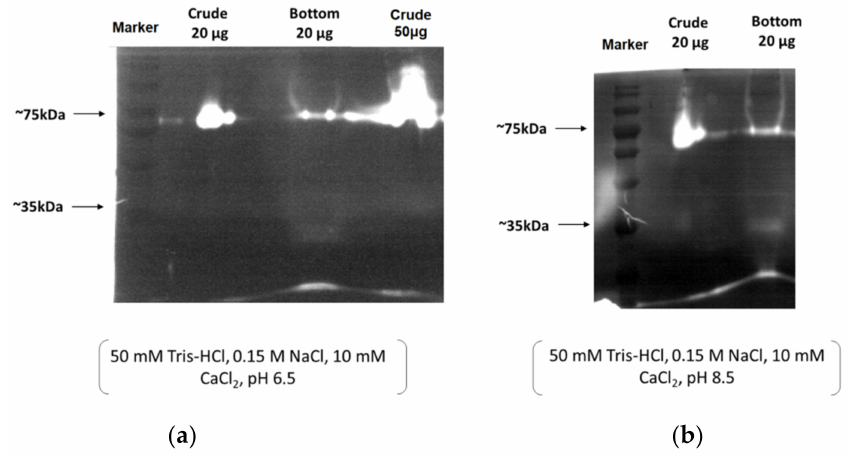
Figure 6. Zymography of the A. platensis lysate and the bottom phase of ATPS with different incubation buffers: ( a ) 50 mM Tris-HCl, 0.15 M NaCl, 10 mM CaCl2, pH 6.5, and ( b ) 50 mM Tris-HCl, 0.15 M NaCl, 10 mM CaCl2, pH 8.5.